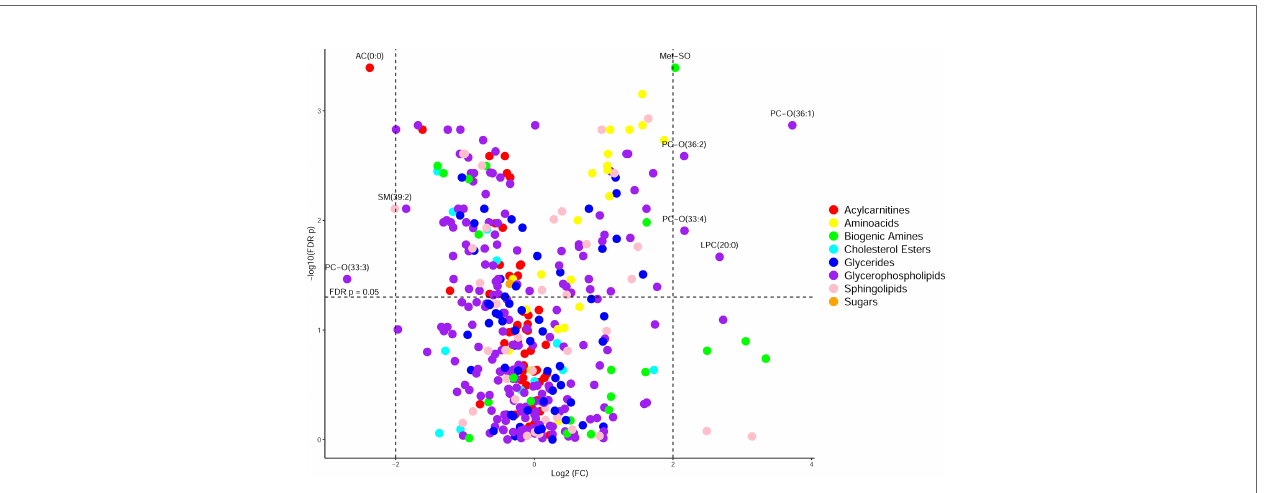
FIGURE 1 | Volcano plot of metabolites organized by class, with the y-axis being -log 10 (FDR p-value) from a Wilcoxon rank sum test and the x-axis being log 2 (fold change) of the values prior to column-wise normalization. Points higher up on the y axis indicate features with greater signi fi cance. Points on the left side indicate features found in less abundance in CF samples and points on the right side indicate features found in greater abundance in CF